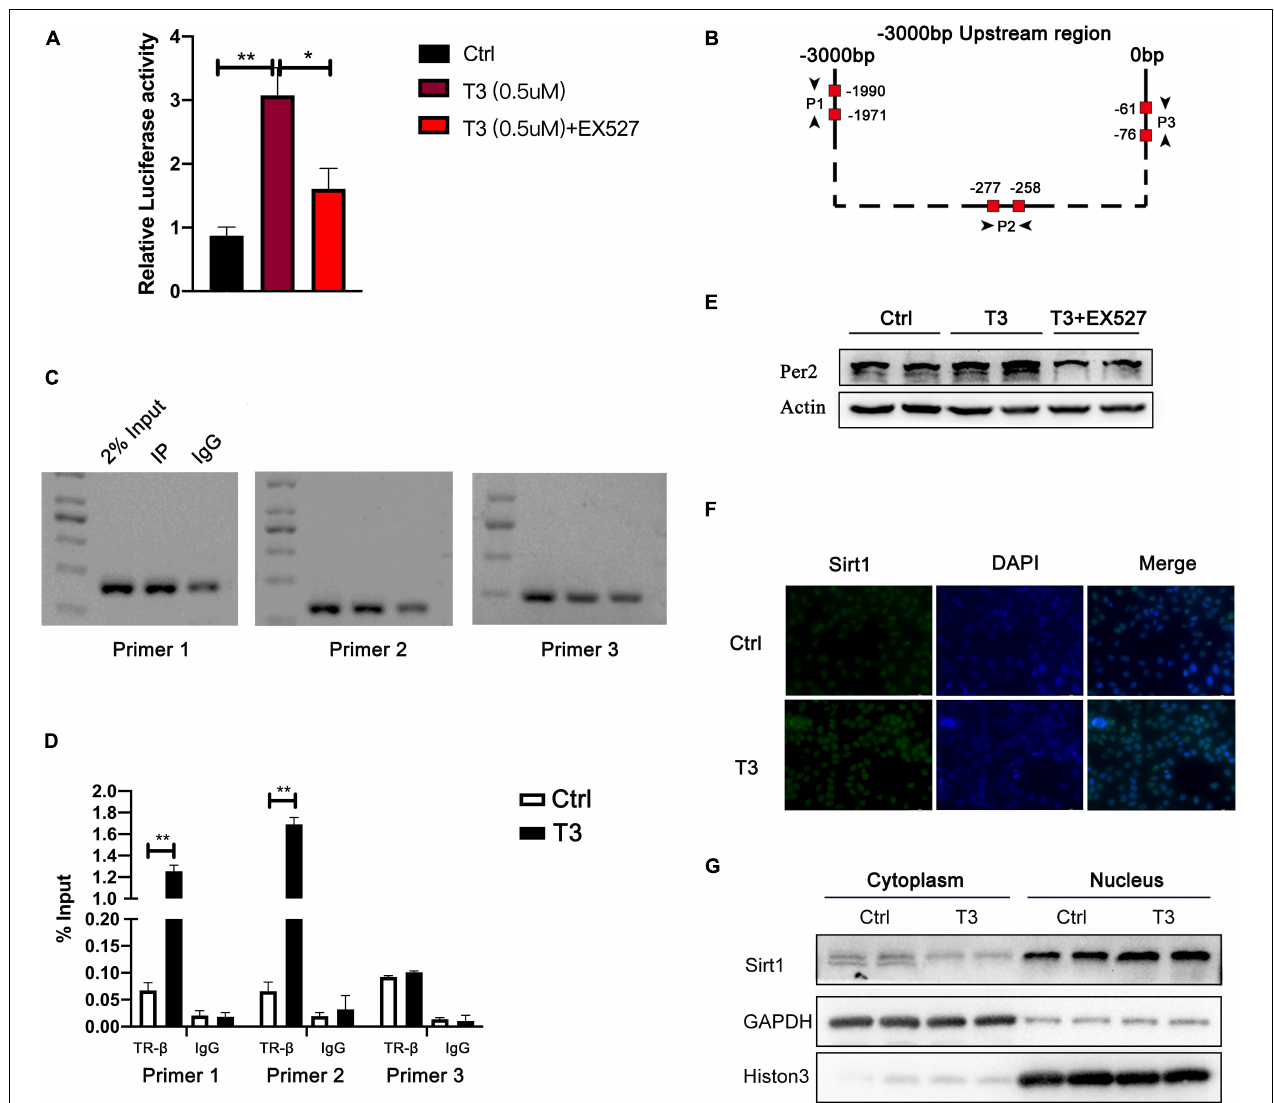
FIGURE 6 | (A) Luciferase reporter activity at 48 h after treatment. (B) Per2 gene upstream region and TR- β binding site analysis. (C) For the predicted binding site, samples of input, TR- β IP, and IgG IP were analyzed by PCR. (D) ChIP-qPCR results (** P < 0.01). (E) Effect of EX527 on T3-induced Per2 expression. (F) Sirt1 immunofluorescence analysis. (G) Nuclear levels of Sirt1 in HepG2 cells treated with T3 for 48